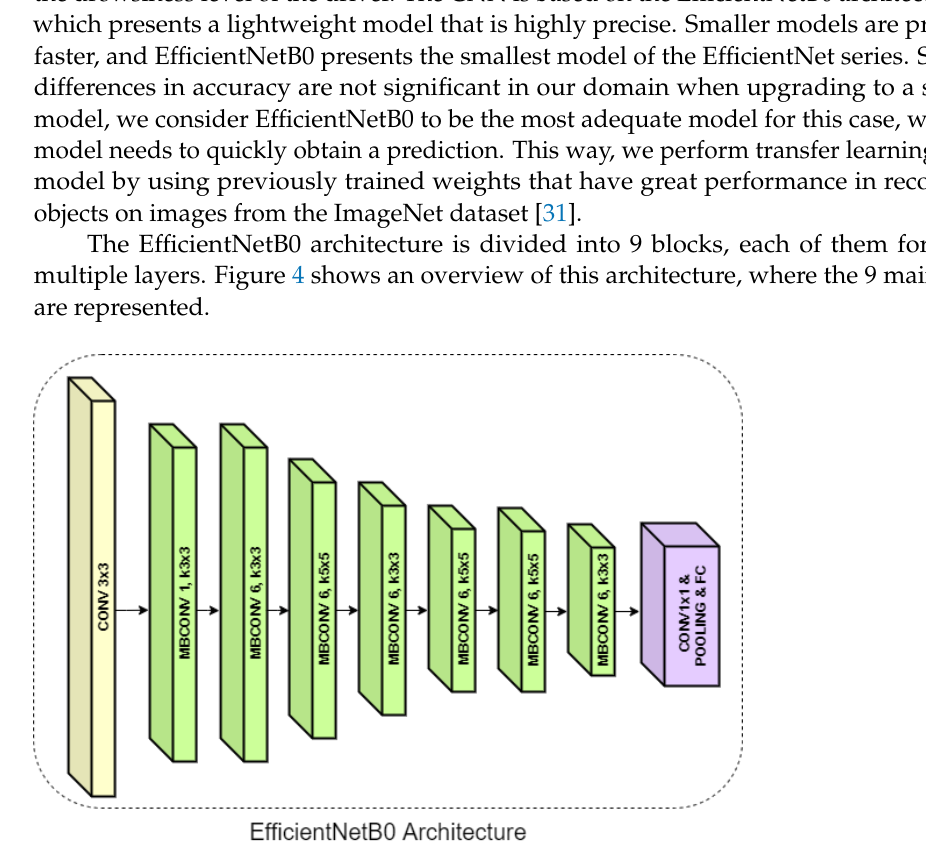
Figure 4. EfficientNetB0’s architecture